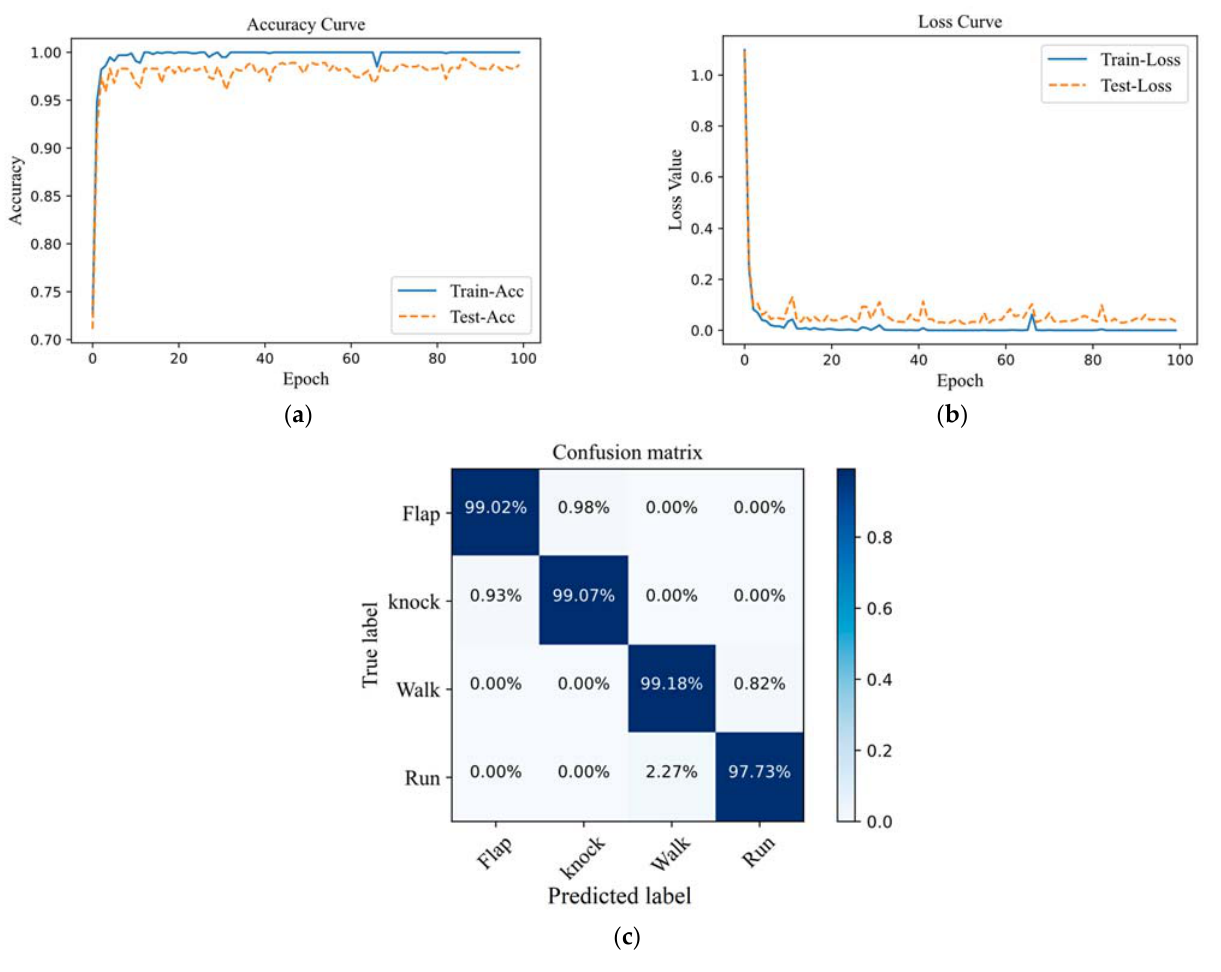
Figure 10. Learning curve and confusion matrix of fiber vibration signal recognition results. ( a ) Accuracy curve; ( b ) loss curve; ( c ) confusion matrix.